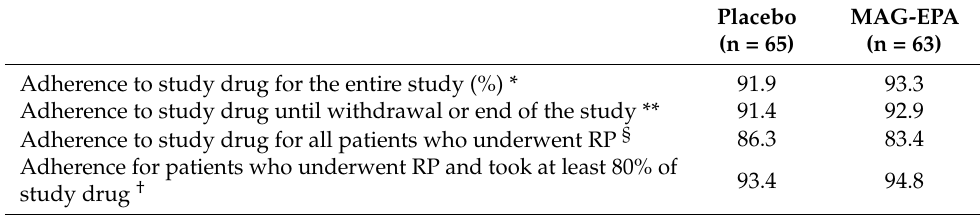
Table 5. Adherence to study drug.